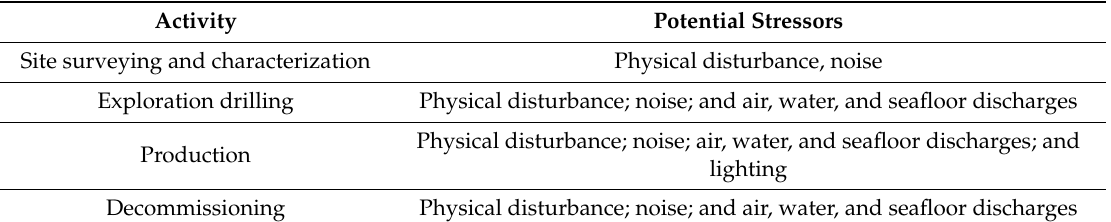
Table 2. O ff shore Oil and Gas Industry Activities and Associated